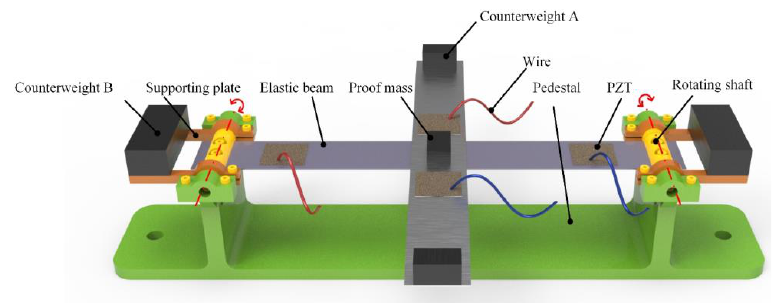
Figure 1. The structure and component parts of the piezoelectric energy harvester.